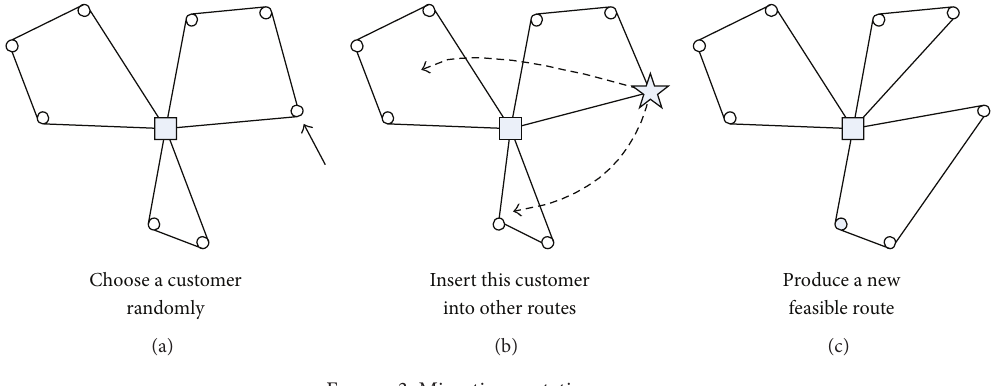
Figure 3: Migrating mutation